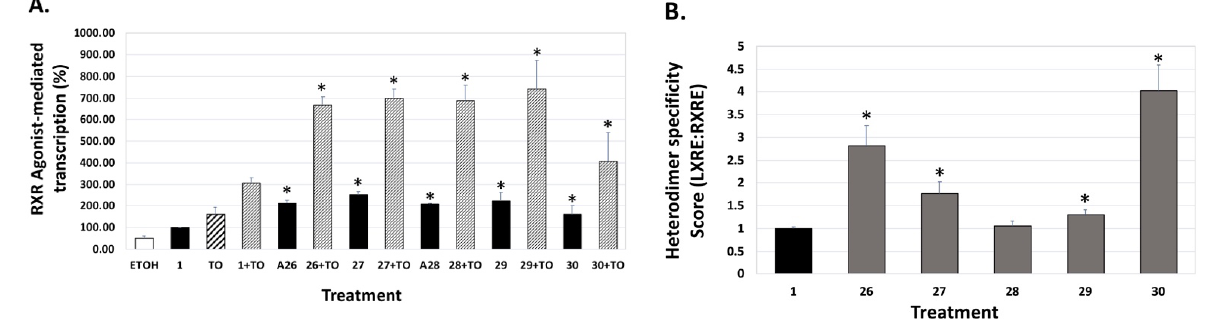
Figure 6. RXR agonist potentiation of LXRE-regulated transactivation with or without the T0901317 LXR agonist . ( A ) U87 glial cells were transfected with an expression vector for human LXR α , an LXRE-luciferase reporter gene with three tandem copies of the LXRE from the human ApoE gene, and a Renilla control plasmid. Cells were transfected for 24 h utilizing a liposome-mediated transfection protocol and then treated with ethanol vehicle, or 100 nM of the indicated compound alone or in combination with 100 nM TO901317 (TO). LXRE-directed activity was compared to compound 1 (Bexarotene), set to 100%. ( B ) The “Heterodimer Specificity Score” was determined by the LXRE:RXRE ratio with compound 1 set to 1.0. All error bars represent standard deviations; the data are representative of at least three independent experiments with six replicates in each treatment group. * p < 0.05 versus control compound 1 .